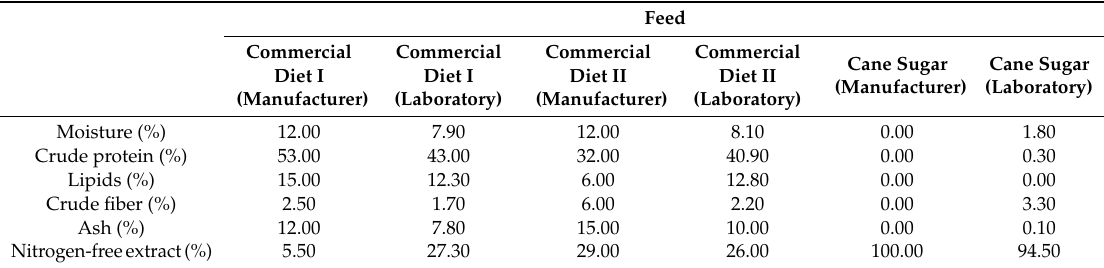
Table 2. Feed composition for tilapia and cane sugar used as a carbon